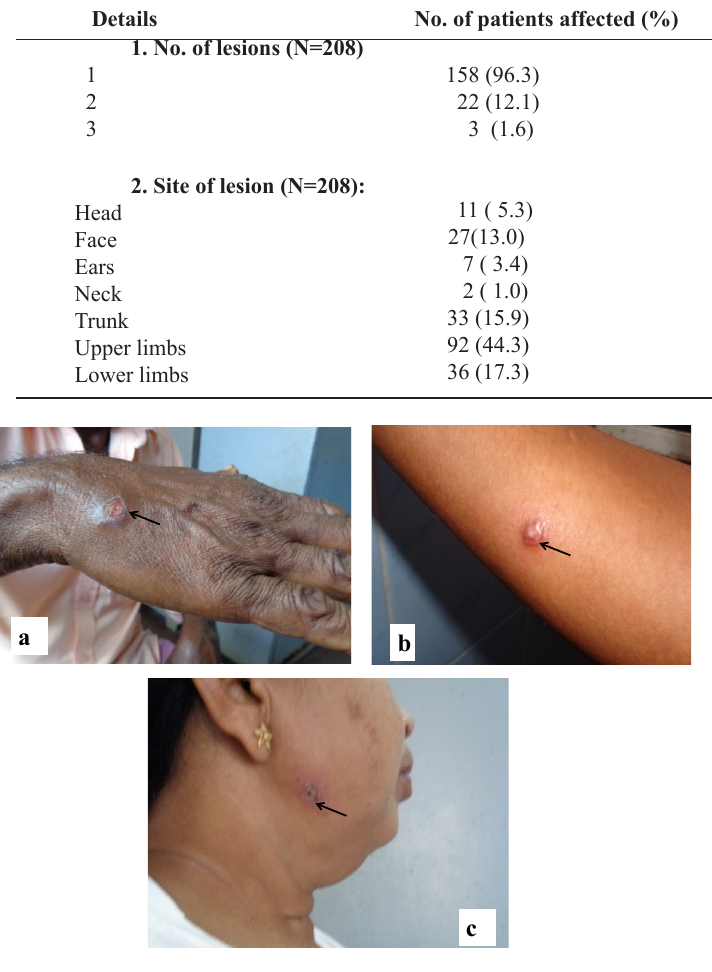
Table 1: Clinical characteristics of CL cases in Hambantota district, Sri Lanka.